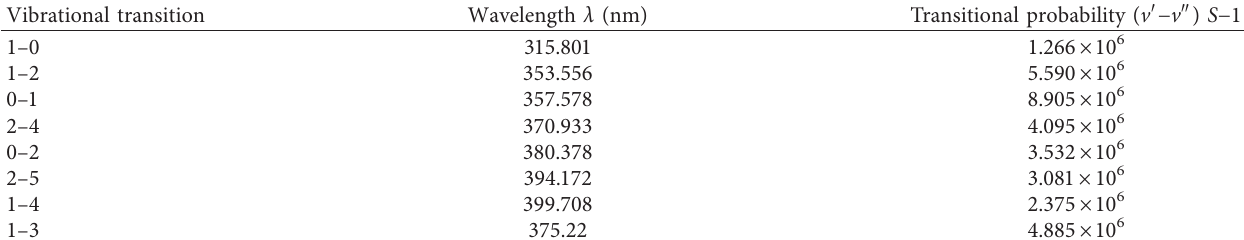
Table 2: Vibrational transition and transitional probability at different wavelengths.